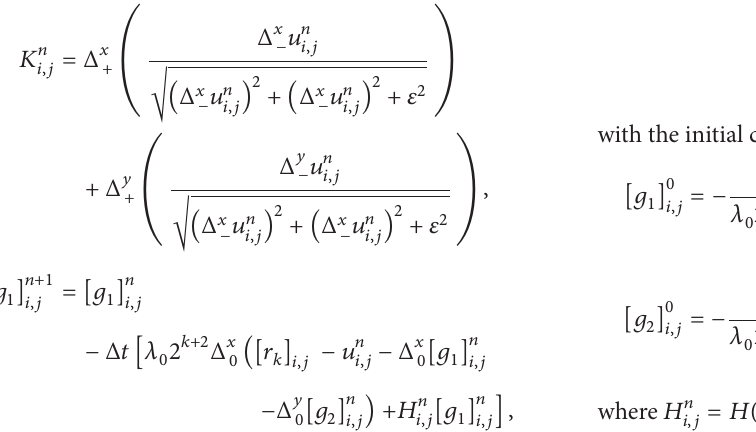
𝑛 where 𝐾 𝑖,𝑗 is the curvature of the level set of , 𝑦 , 𝑛Δ𝑡) , defined (𝑥 𝑖 𝑗